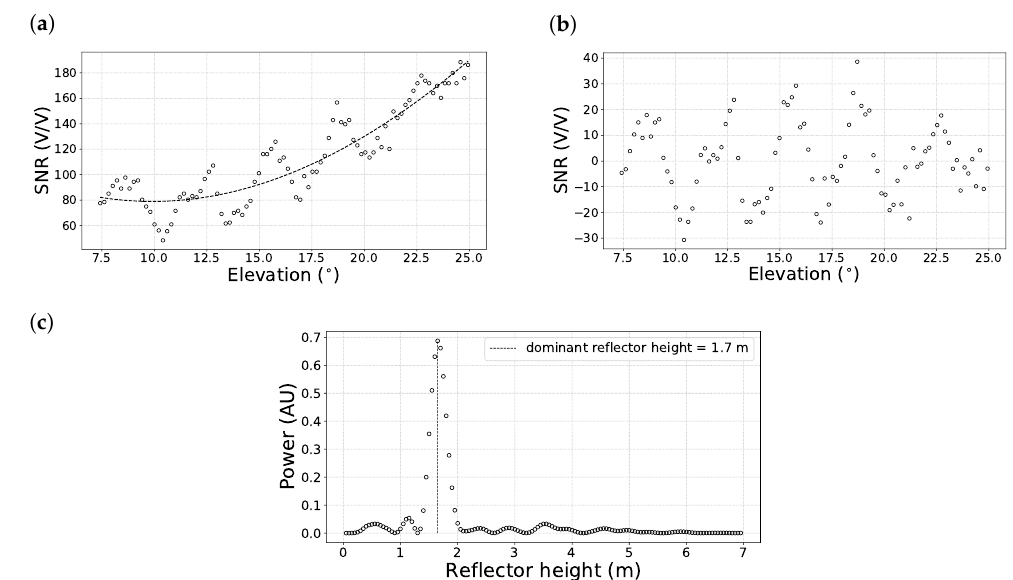
Figure 3. ( a ) Linearized signal-to-noise ratio (SNR) data for G13 satellite rising track on December 5, 2012 at ROB1 station. The interference between the direct and reflected component is evident for elevation angles lower than 30 ◦ . The gray trend, driven by the transmitted signal power and the antenna gain pattern, is represented by a second order polynomial and removed in the multipath analysis. ( b ) Isolated multipath contribution after the removal of the second order polynomial describing the signal direct component. ( c ) Lomb–Scargle periodogram of the same satellite track. Frequencies on the x axis are reported as reflector heights.